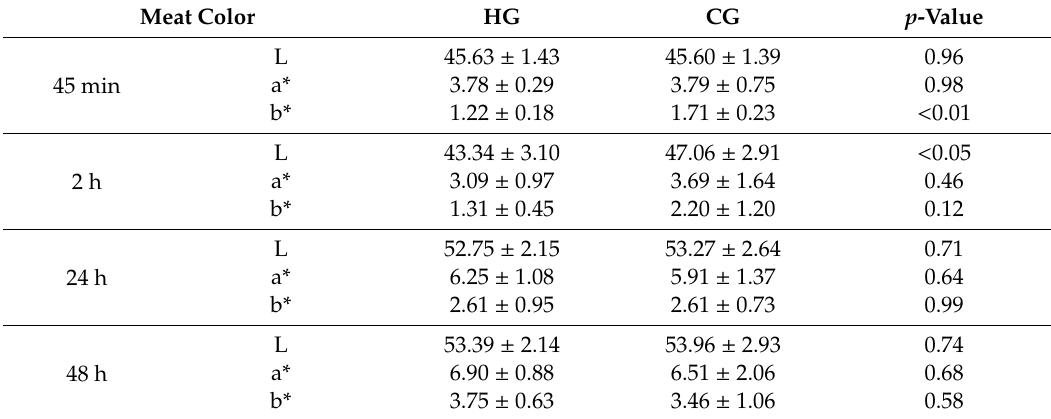
Table 8. E ff ect of gentle handling on meat color of finishing pigs (mean ± standard deviation) ( p < 0.05).